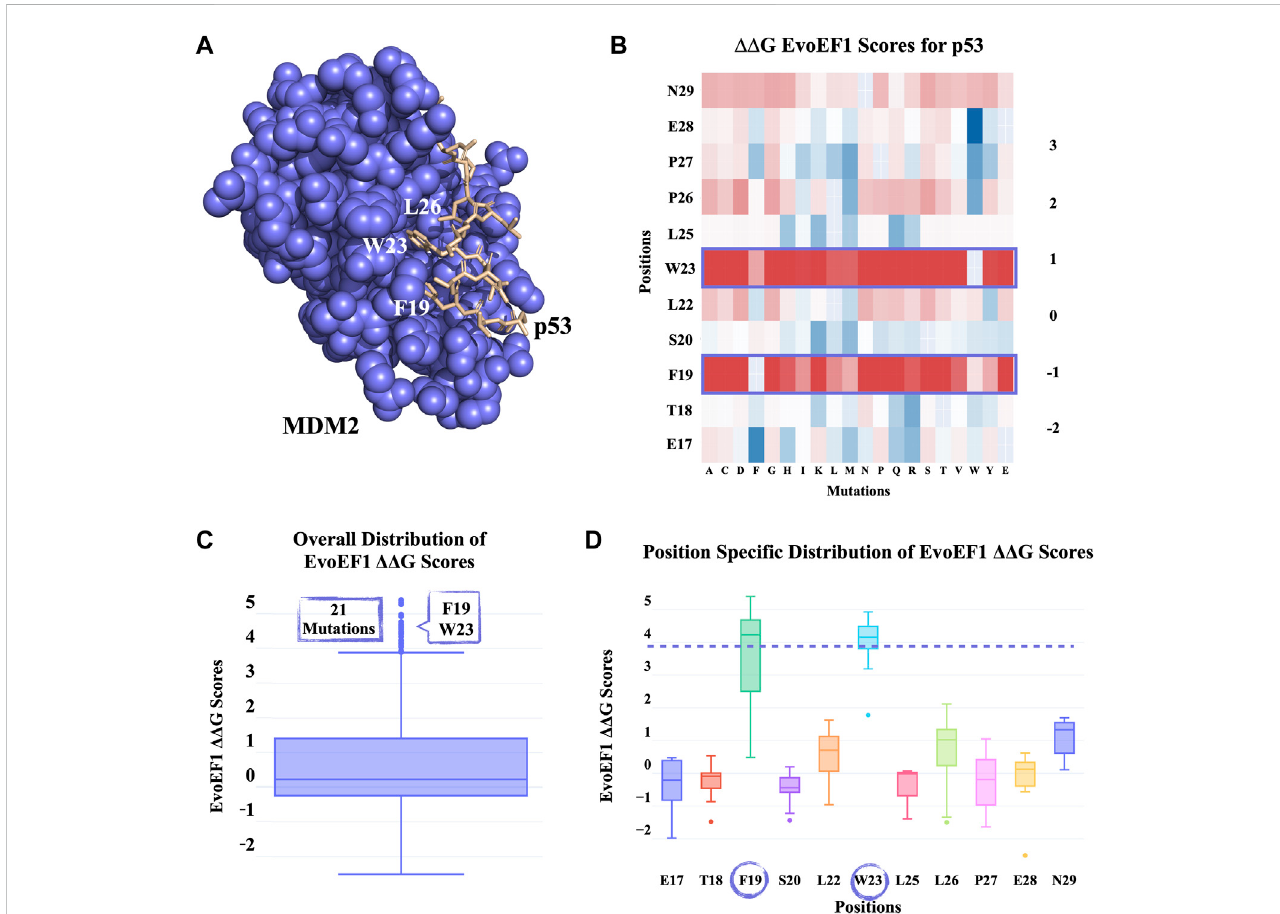
FIGURE 3 PROT-ON results on p53 from the MDM2-p53 complex with default run parameters. (A) Slate and wheat colors show MDM2 and p53 proteins, respectively. The critical p53 residues for the MDM2-p53 interaction are depicted in sticks. (B) EvoEF1 mutational energy heatmap. The detected critical positions are marked with a rectangle. (C) The box-and-whisker statistical analysis of the EvoEF1 mutation scores. There are 21 positive outliers detected by EvoEF1. (D) Position-speci fi c distribution of energy scores for p53 calculated by EvoEF1. The purple dash line represents the upper whisker end value, as given in Figure 3C. The encircled residues indicate the position of outlier